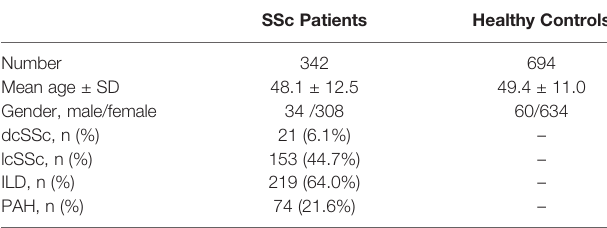
TABLE 1 | Clinical characteristics of patients with SSc and healthy controls.